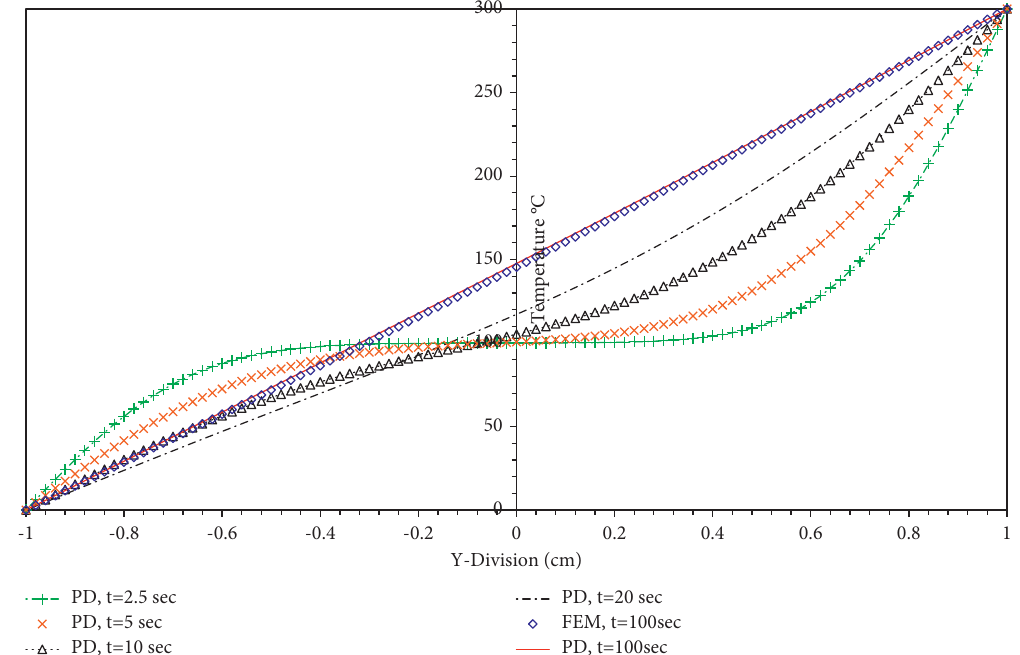
Figure 9: Temperature values for nonsymmetric boundary